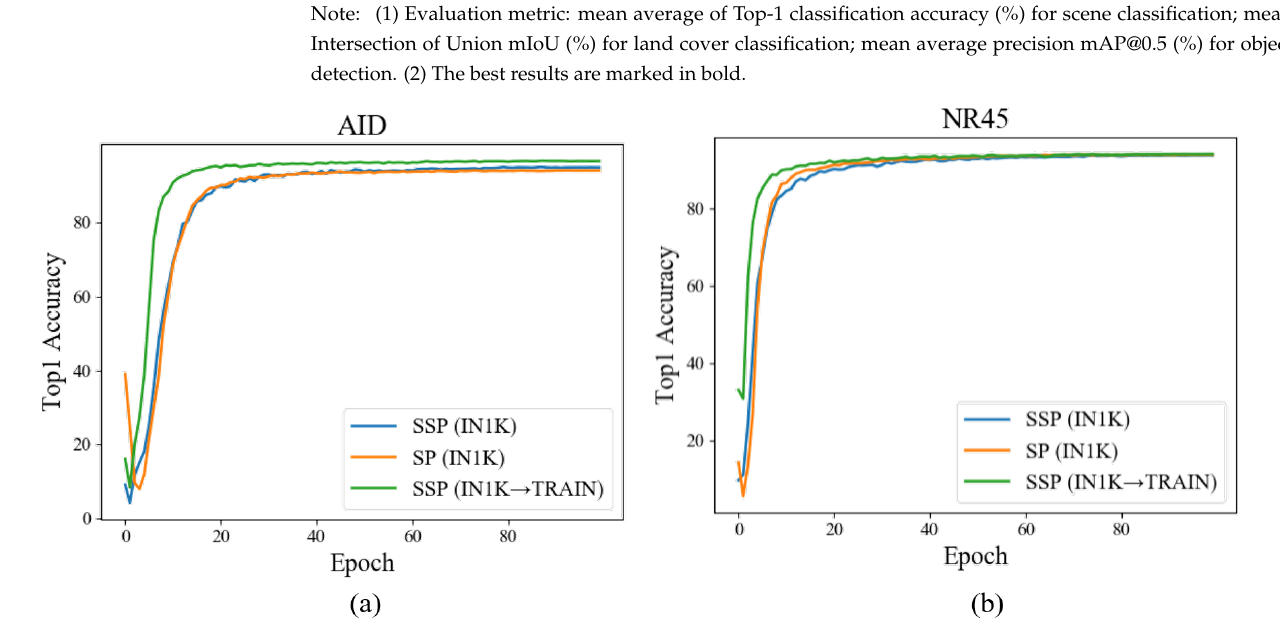
Figure 5. The accuracy curves of three different model pre-training strategies. ( a ) represents the accuracy curves on AID [19]; ( b ) represents the accuracy curves on NR45